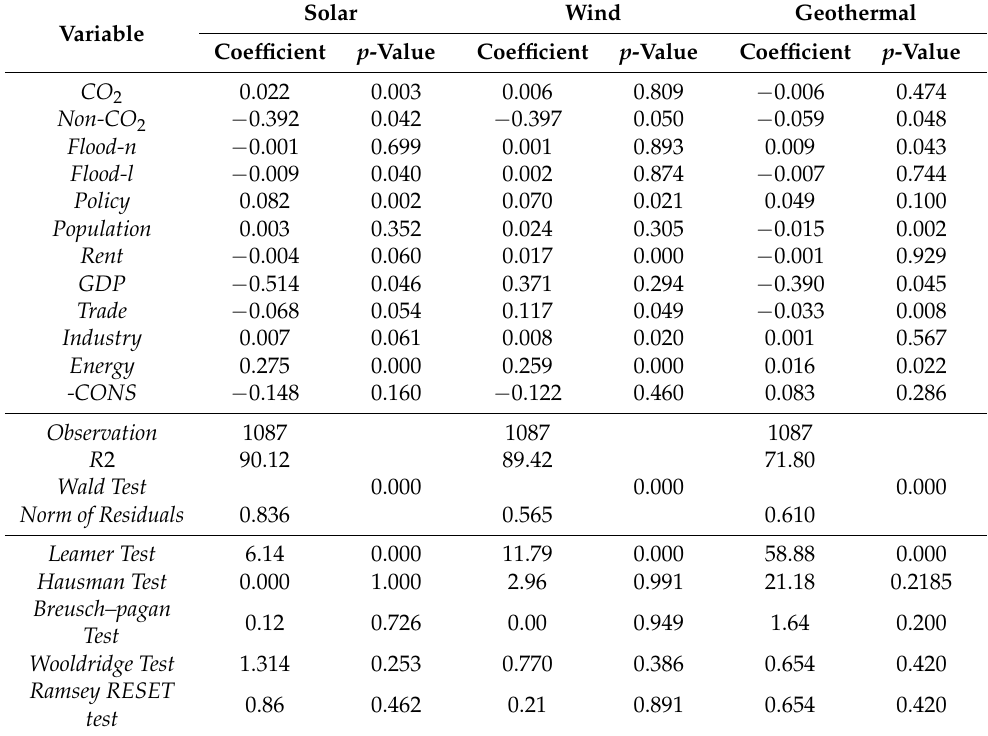
Table 5. The estimated